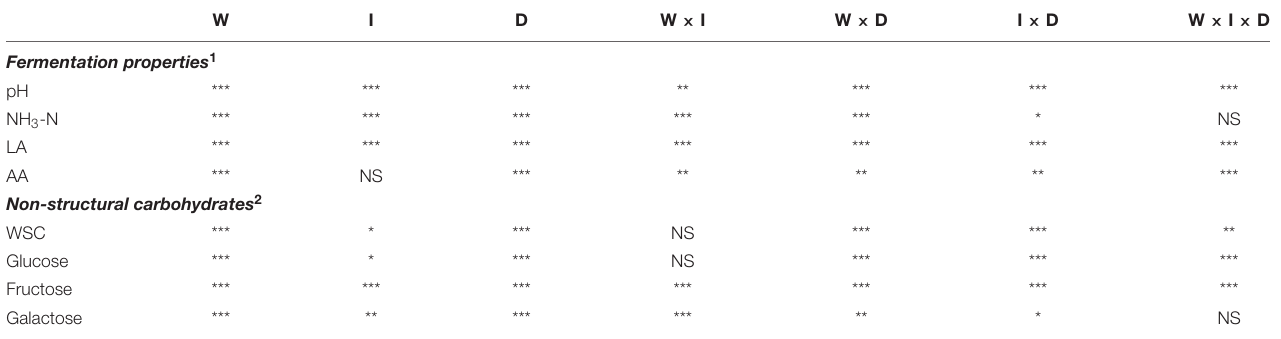
TABLE 1 | Effects of wilting (W), inoculation (I), ensiling days (D), and the interactions of these factors on the fermentation properties and non-structural carbohydrates of alfalfa silage. W